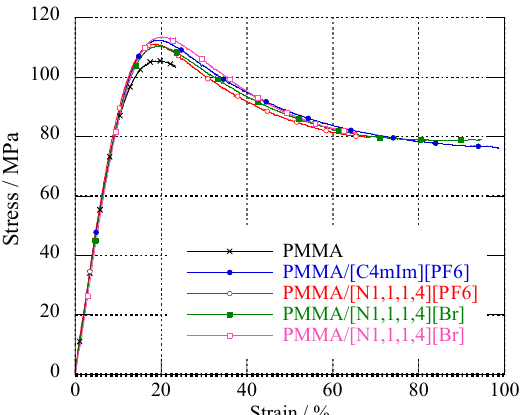
Figure 6. Strain–stress curves in uniaxial tension for neat PMMA and IL-modified PMMA materials (295 K, 50% RH, 2 mm · min − 1 ). Table 4. Effect of ILs on the tensile properties of IL-modified PMMA at 295 K. (50% RH, 2 mm·min − 1 ).